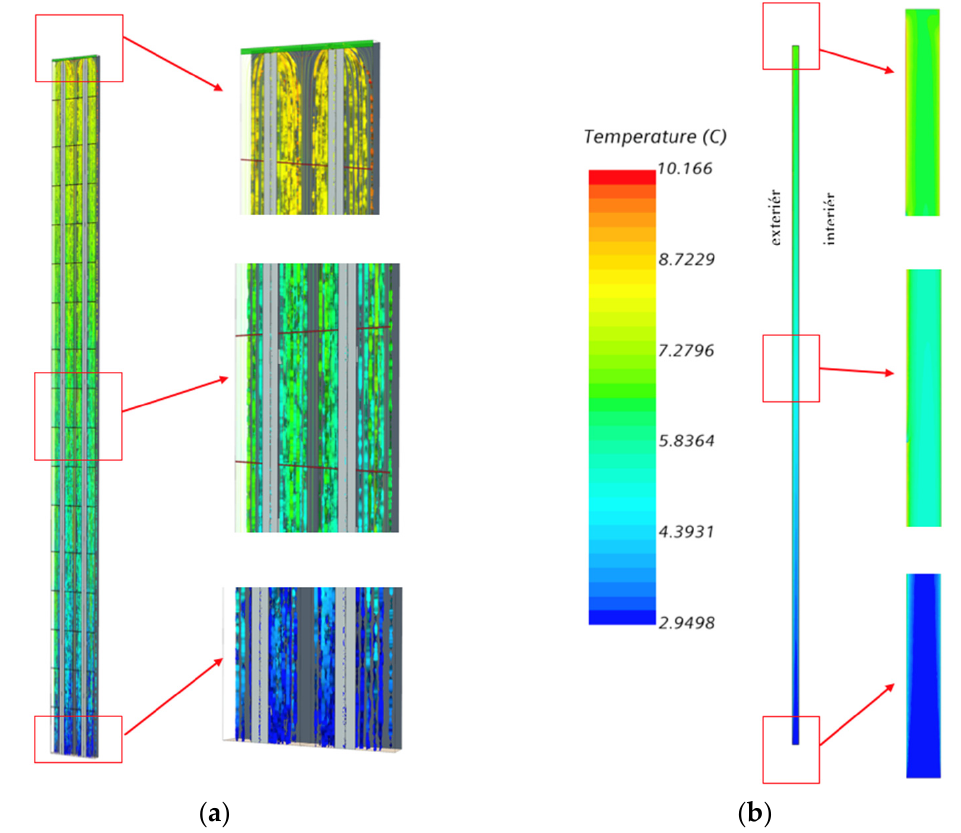
Figure 14. ( a ) Visualization of streamlines in ventilated gap of façade—3D view. ( b ) Visualization of temperature field in façade vertical cross section in winter temperature extreme.